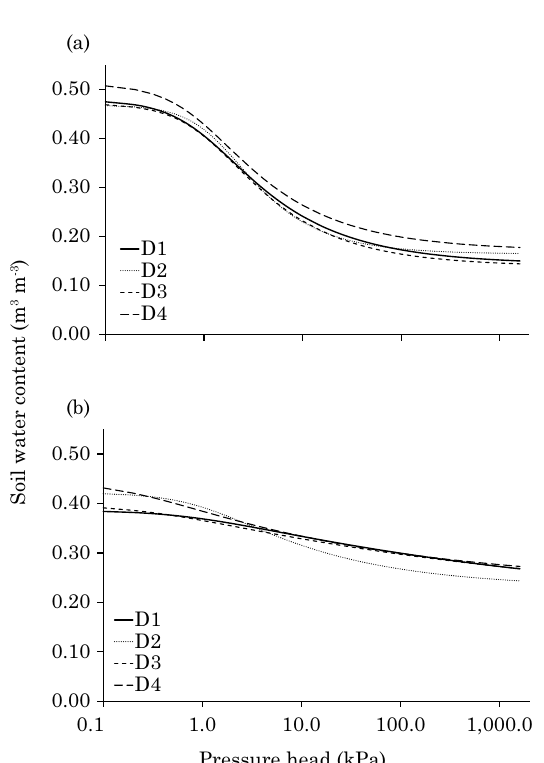
D2, 0.333 - D3, and 0.340 m 3 m -3 - D4 for the fallow